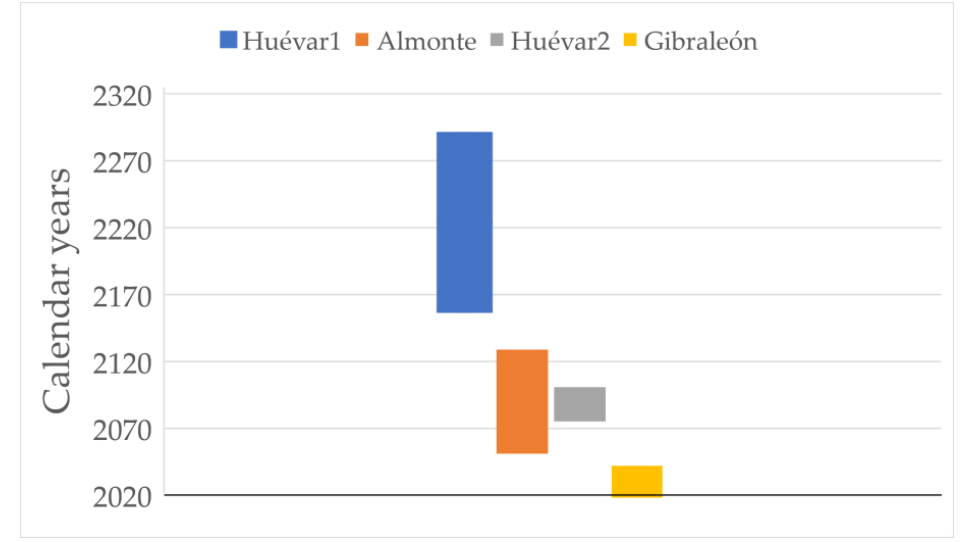
Figure 4. Predicted lifespan of the four plots studied according to the rate of cover loss rate. The end points of the bars indicate upper and lower limits at 95% confidence level.